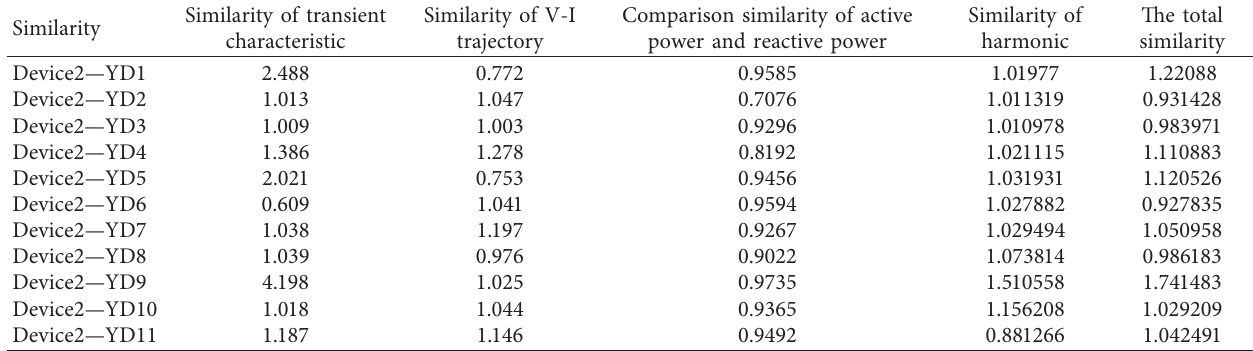
Table 10: Similarity results of device 2.